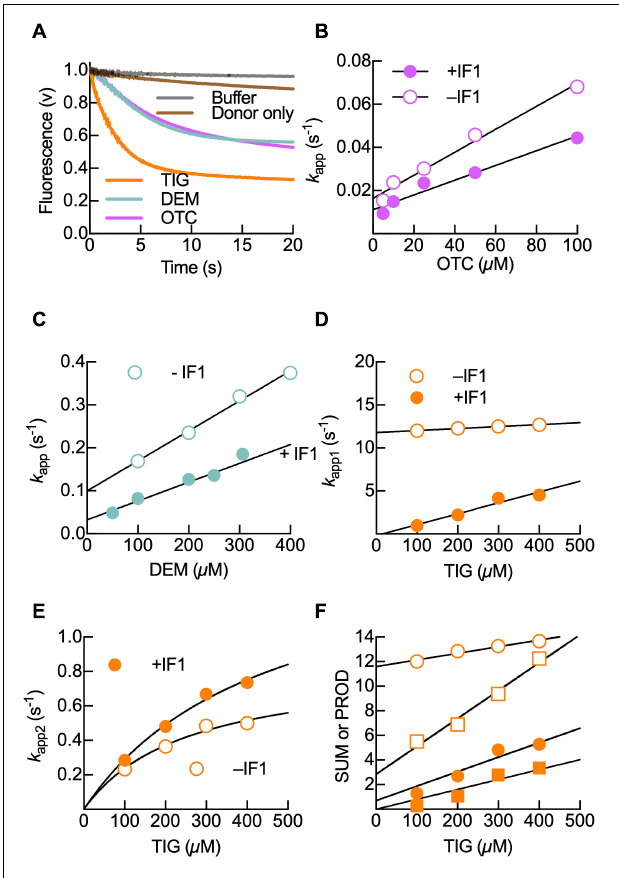
FIGURE 2 | Kinetics of 30S-bound IF3 DL compaction upon binding of Otc, Dem, and Tig. (A) Time courses of IF3 DL fluorescence change during binding of 100 µ M Tig (orange), Dem (aquamarine), or Otc (Pink) to 0.05 µ M 30S–IF3 DL complexes. No acceptor control is shown in brown, while the gray trace represents the dilution control upon mixing 0.05 µ M 30S IF3 DL complexes with buffer. Shown time courses result from six to eight averaged replicates. Apparent rate ( k app ) dependence on Otc (B) , Dem (C) , and Tig (D,E) in the absence (open circles) or the presence (full circles) of 0.15 µ M IF1. Continuous lines in panels (B–D) show linear regressions of the bimolecular encounter of tetracyclines with the corresponding complex. The continuous lines in panel (D) show a hyperbolic fitting for the accommodation step observed for Tig binding. (F) Analytical solution for the mechanism IF3 DL conformational change upon Tig interaction with the 30S subunit using a two-step model. Plots of the sum (circles) and product (squares) of k app1 and k app2 linearly depended on Tig concentration, allowing to calculate all four microscopic constants ( k 1 , k − 1 , k 2 , and k − 2 ) (see section “Materials and Methods”). Error bars in panels (B–F) indicate standard errors of the